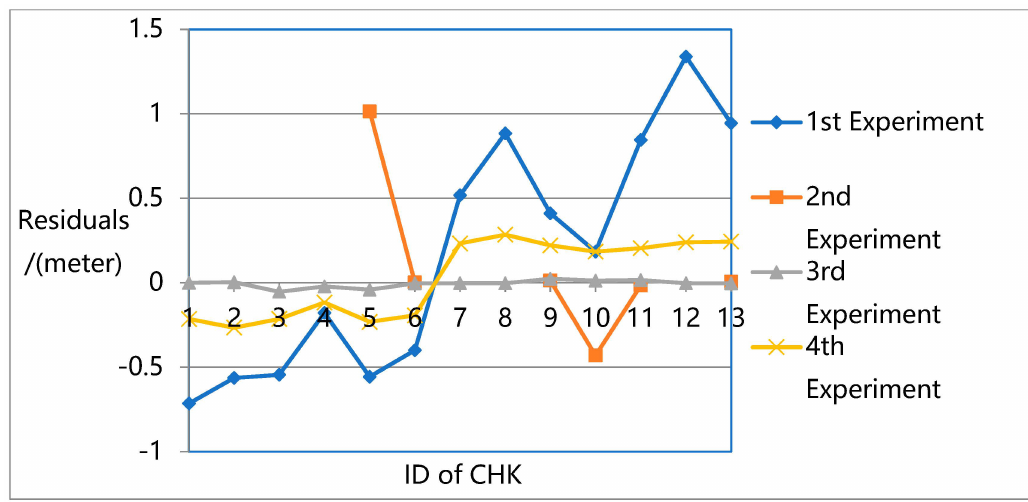
Figure 13. Residuals Plot of CHKs in X-direction.